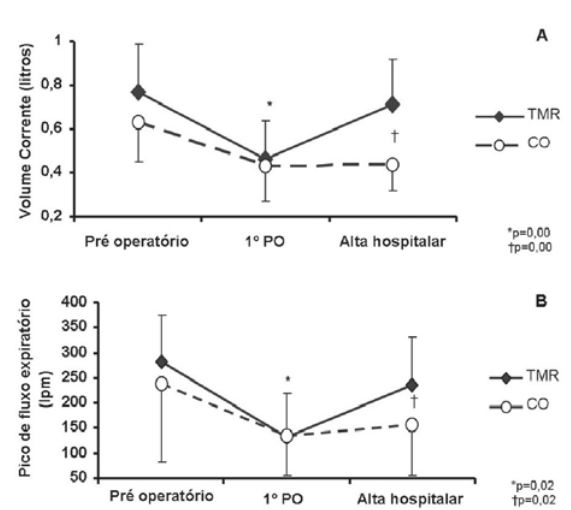
Fig. 1 - (A) Volume corrente (VC) nos dois grupos estudados em três momentos: pré- operatório, primeiro dia de pós-operatório (1º PO) e momento da alta hospitalar; (B) Pico de fluxo expiratório nos dois grupos estudados em três momentos: pré-operatório, primeiro dia de pós-operatório (1º PO) e momento da alta hospitalar. CO = grupo controle; TMR = grupo treinamento muscular respiratório; lpm = litros por minuto; *1º PO vs. pré- operatório; † TMR vs. CO